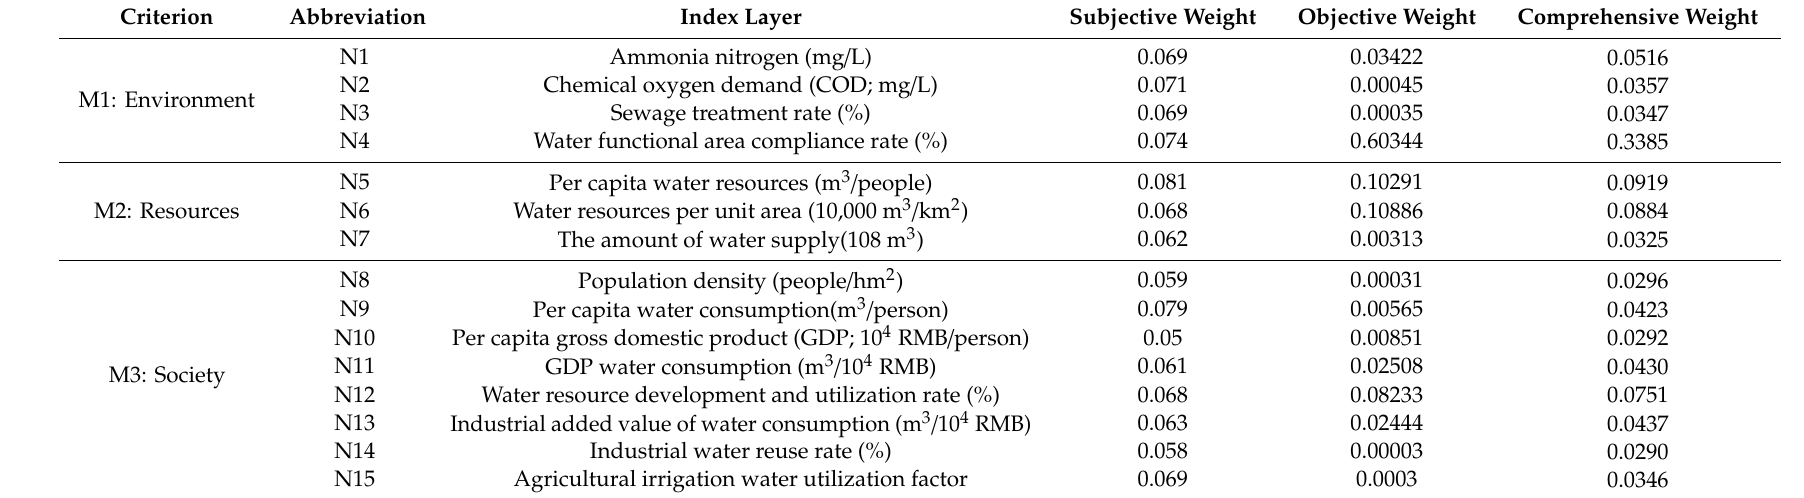
Table 2. The assessment system for water resource assets and the corresponding